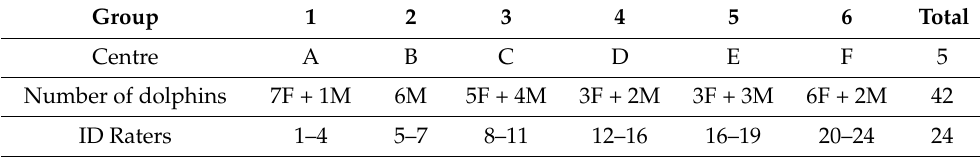
Table 2. Description of the six groups of dolphins that participated in the current study.